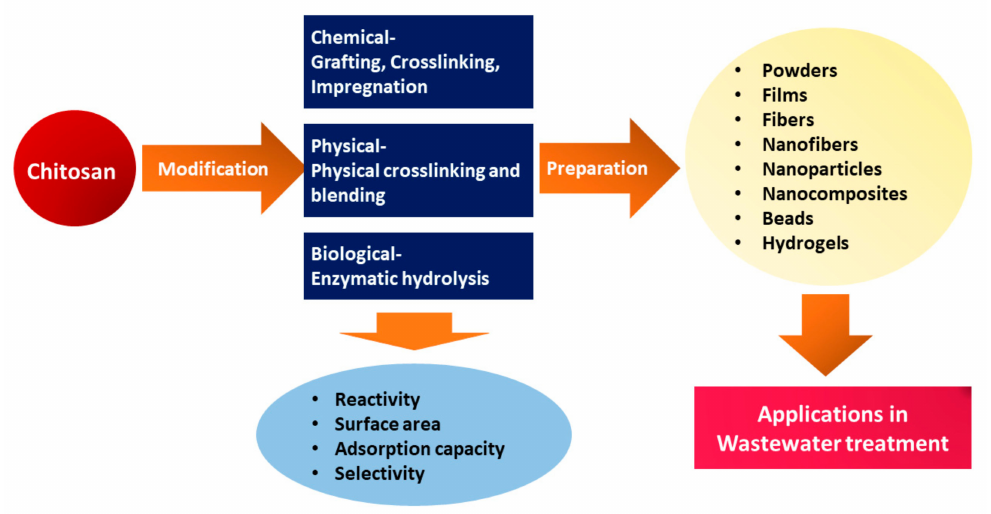
Figure 4. Schematic representation of modification of CS and CS-based materials preparation for wastewater